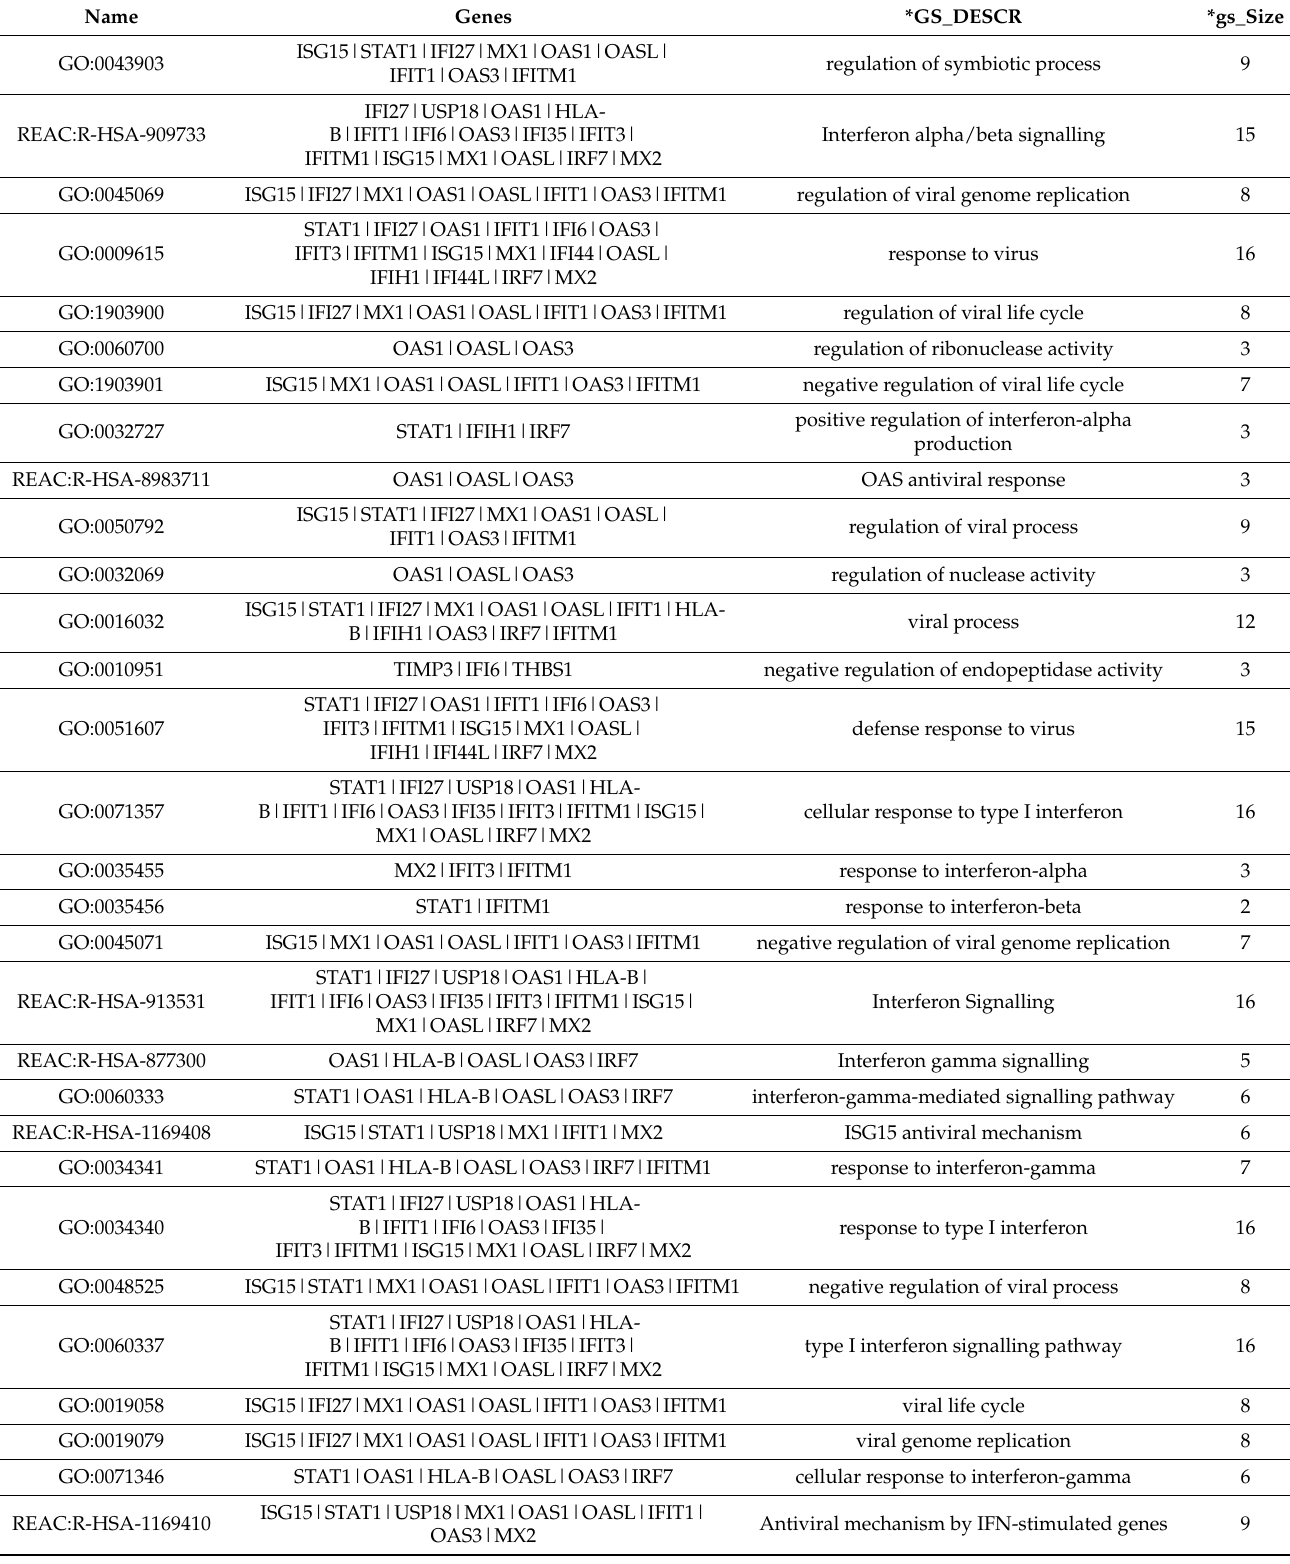
Table 1. Dataset retrieved from the pathway enrichment analysis using the g:profiler and Cytoscape protocols [78–80], representing the number of IRDS genes involved in a particular